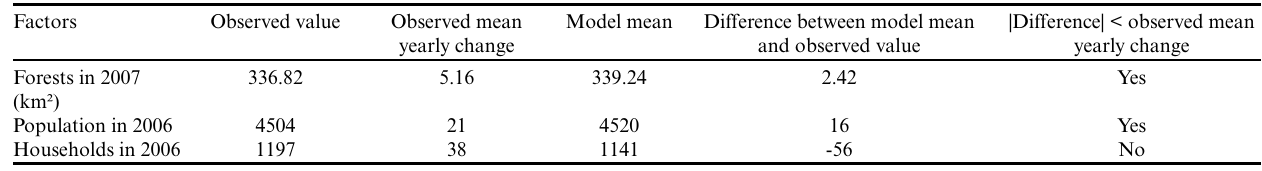
Table 5 . Comparison of model predictions of forest area, population size, and household number to observed